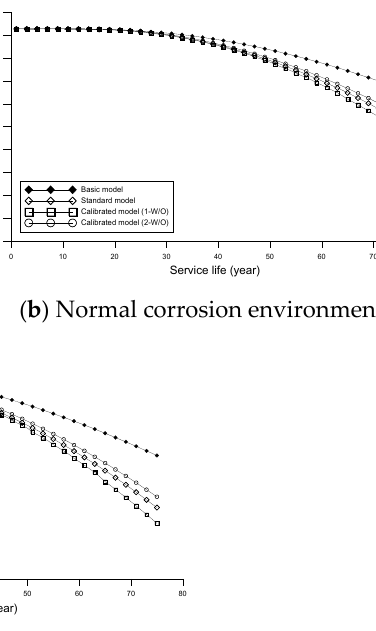
Figure 10. Reliability degradation under heavy traffic characteristics (with previous inspection).